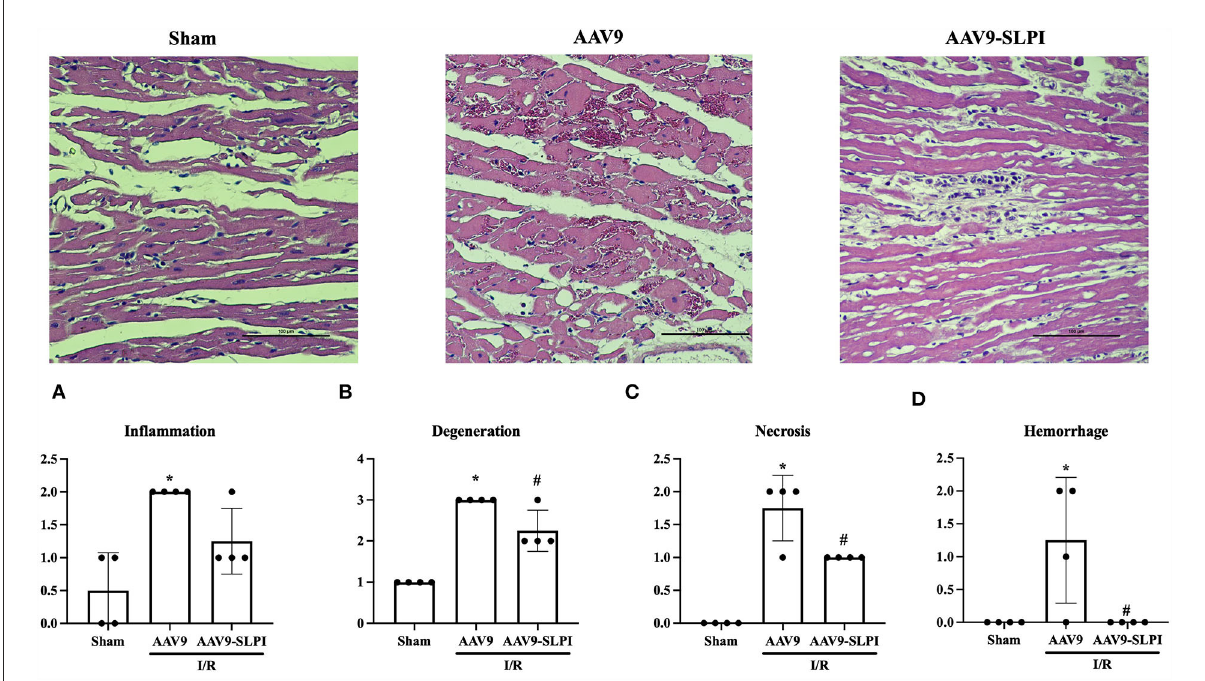
FIGURE5 Myocardial histology parameters consists of inflammation (A) , degeneration (B) , necrosis (C), and hemorrhage (D) (* p < 0.05 vs. sham) ( # p < 0.05 vs. AAV9).